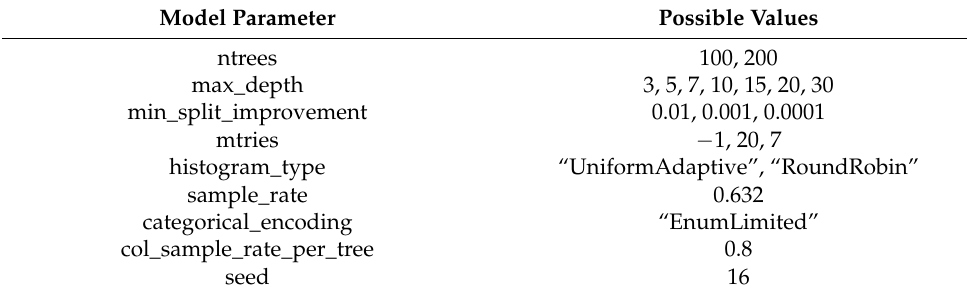
Table 10. Tuning Parameters for Random Forest Severity Models.